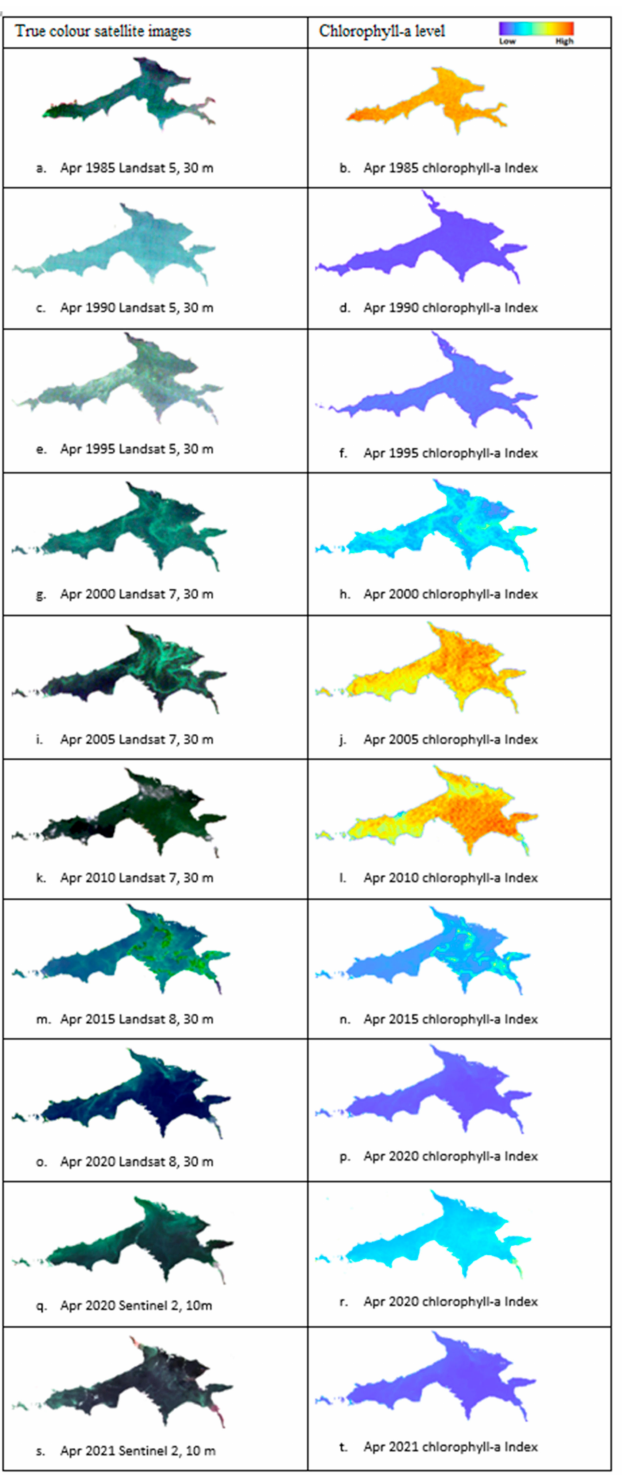
Figure 8. Chlorophyll-a concentrations in the Hartbeespoort Dam between 1980–2021 from Landsat and